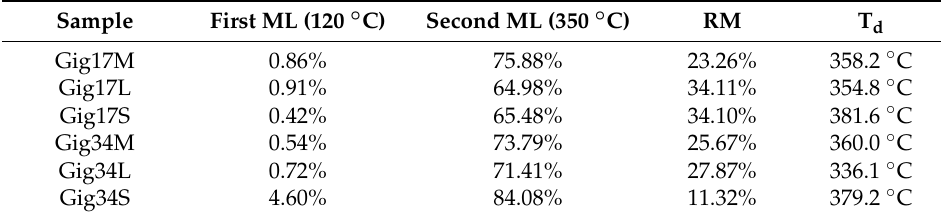
Table 5. TGA results including first and second mass loss (ML), residual mass (RM), and decomposition temperature (T d ) for two M . x giganteus lignins. Mixtures (Gig17M, Gig34M), stem-derived